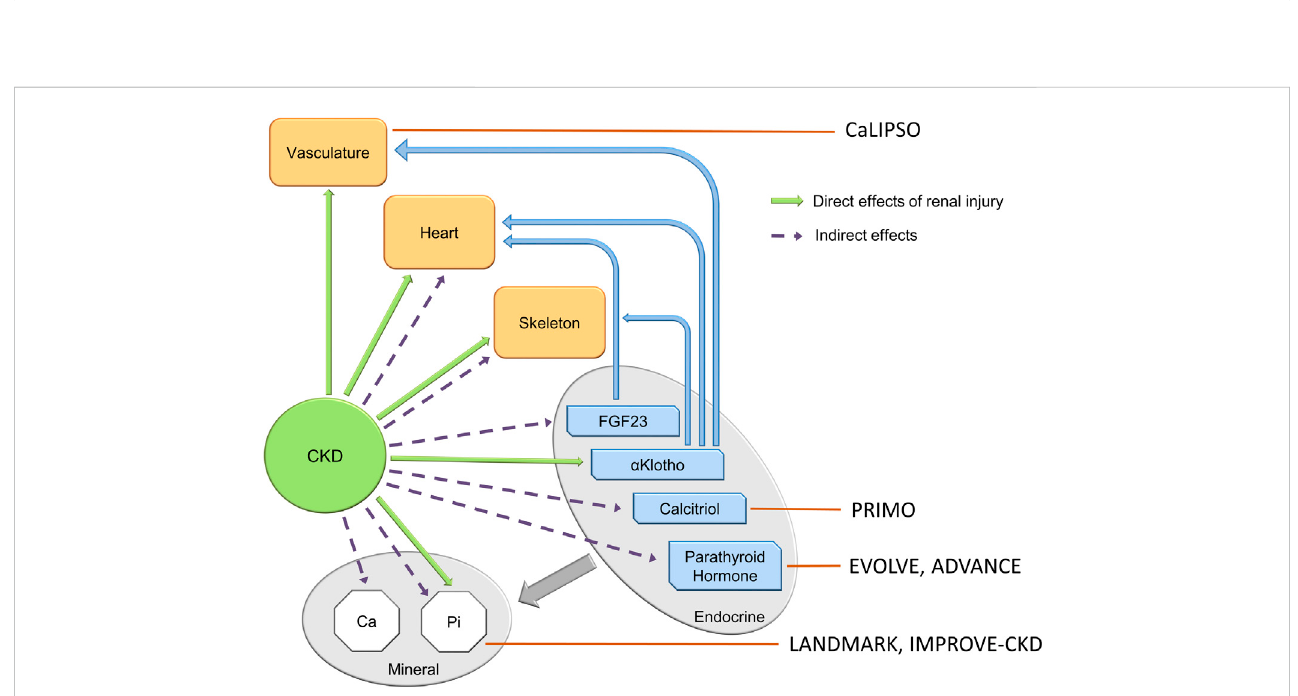
FIGURE 2 The components of the CKD-MBD, and the targets of clinical trials of attempted therapy. Clinical trials in the CKD-MBD to date have targeted late components of the syndrome, and have not altered cardiovascular outcomes. Small observational trials of romosozumab targeting the skeleton in dialysis patients (not shown in the fi gure) reveal increased bone mineral density at lumbar and femoral bone sites at 12 and 24 mos. See section on bone — vascular